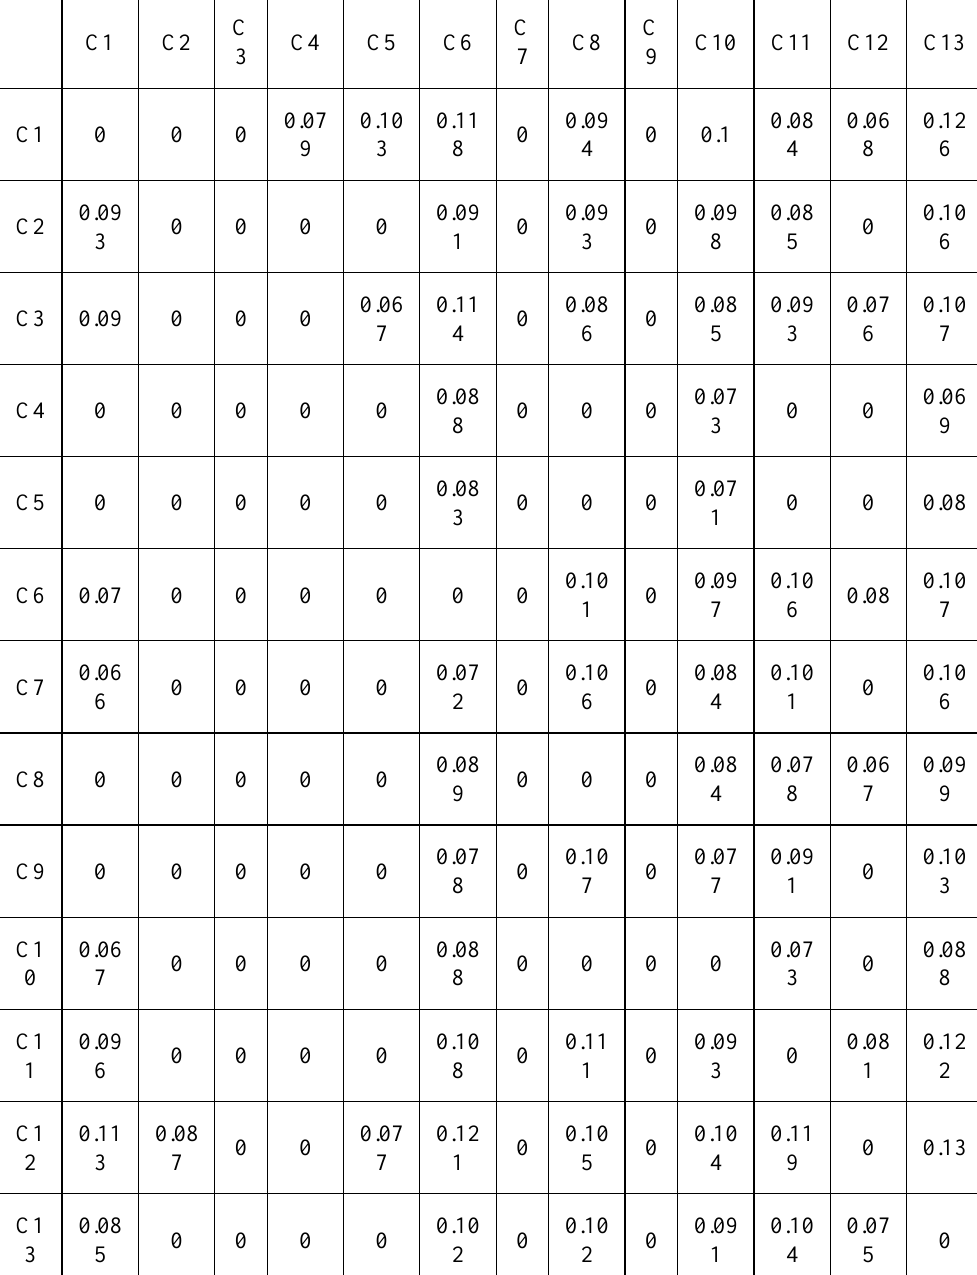
Table 4. The crisp total- relationships matrix by considering the threshold